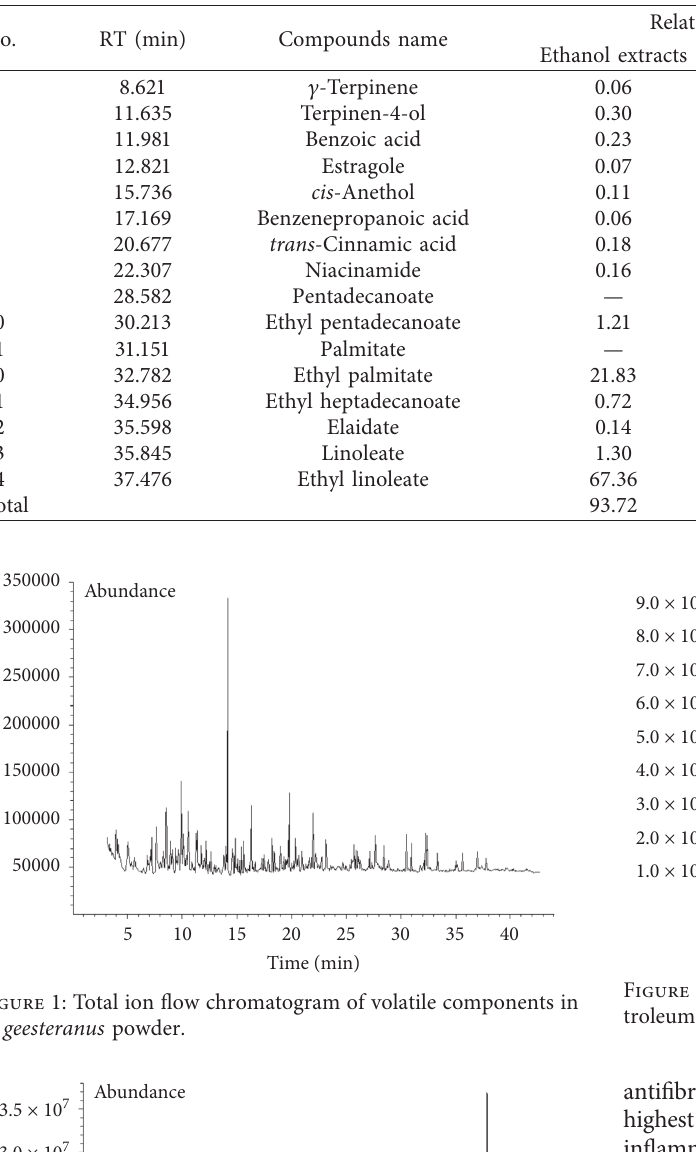
Table 2: Compounds and relative percentages of ethanol extract and petroleum ether extract.